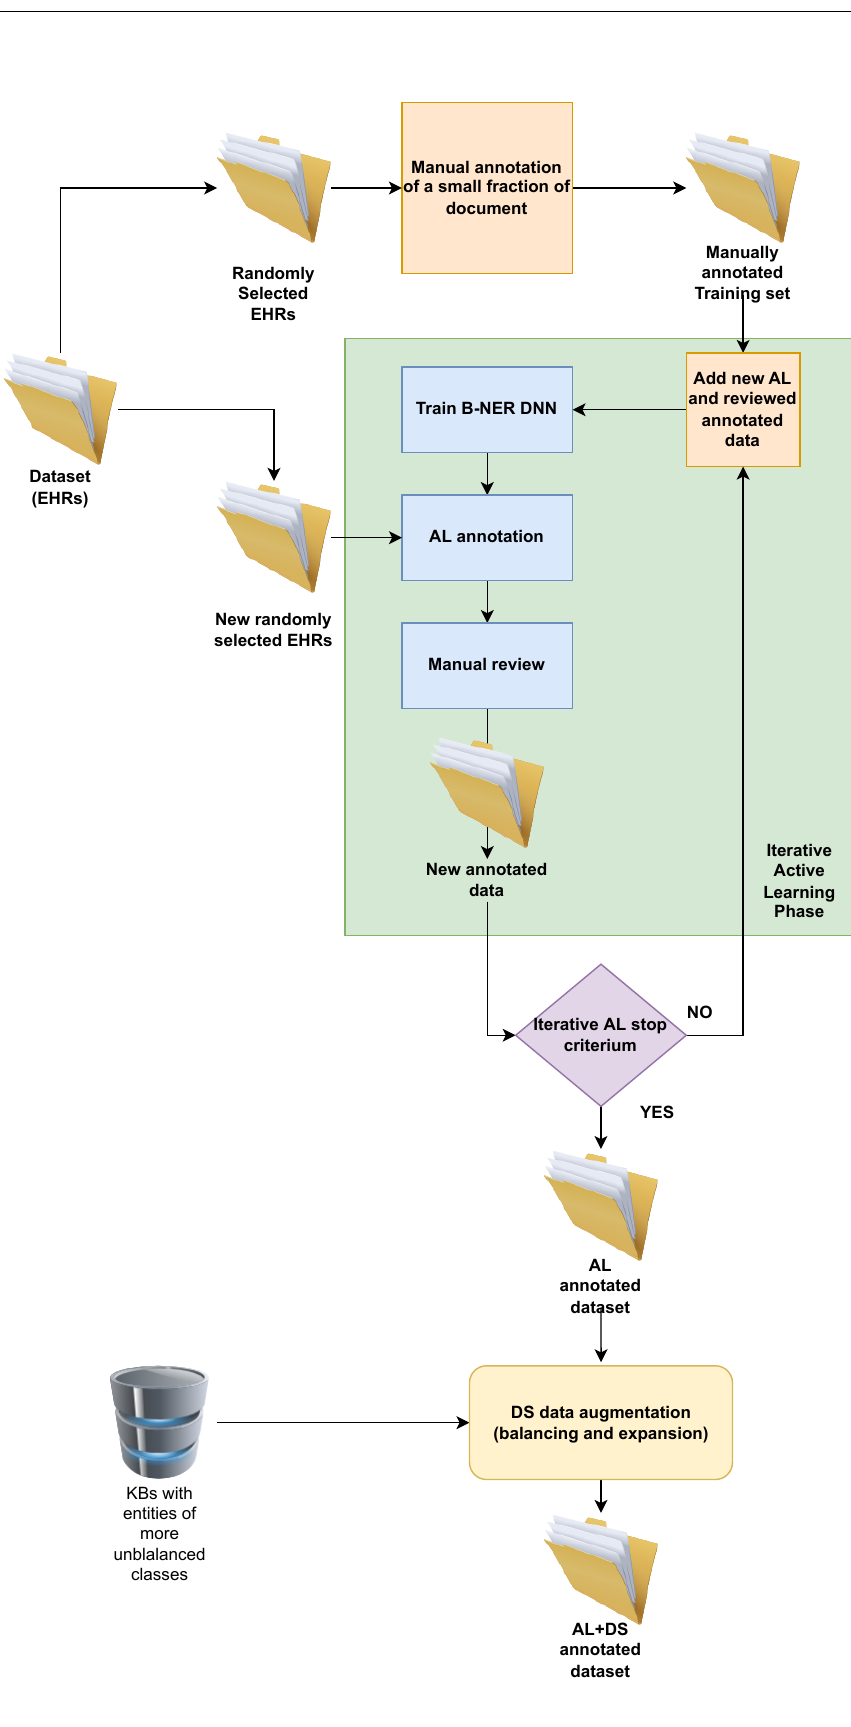
Figure 2. Schematic representation of the active learning annotation